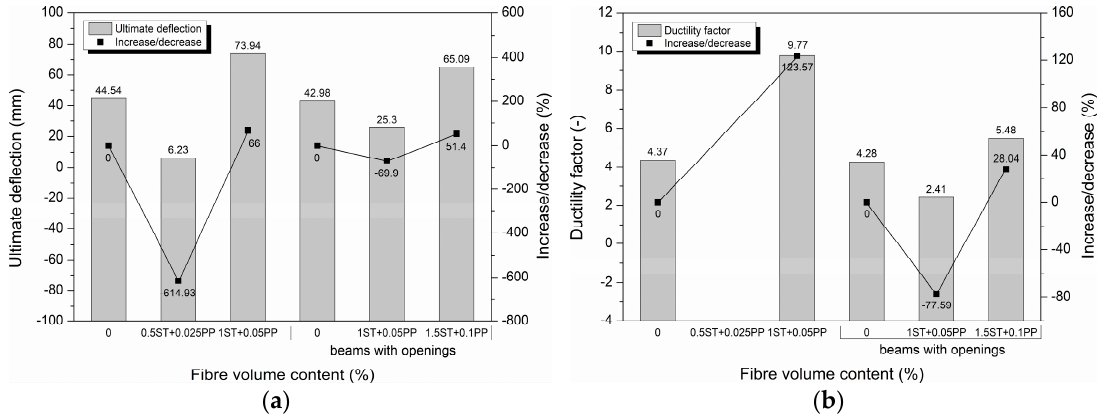
Figure 10. Comparison of beam ( a ) ultimate deflection and ( b ) ductility factor.